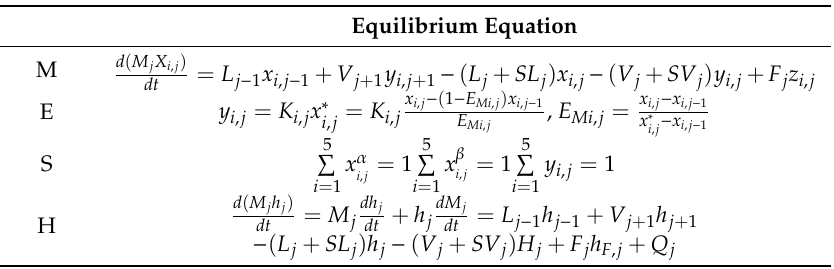
Table 2. Dynamic mathematical model of the distillation